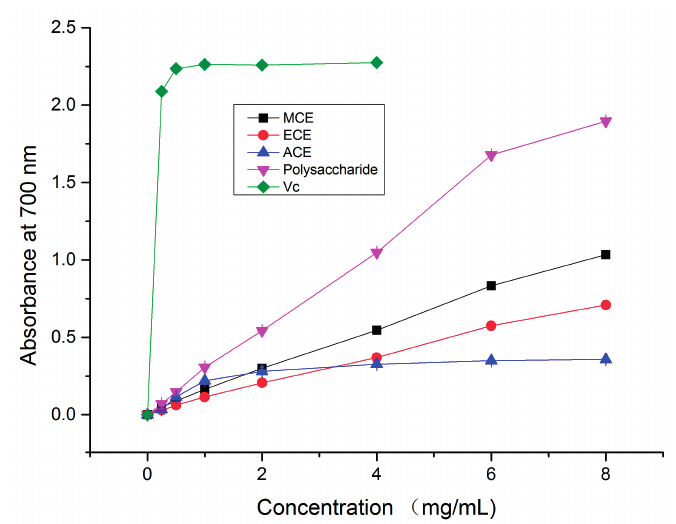
Figure 4. Comparison of reducing power of different extracts and Vc by spectrophotometric detection of the Fe 3+ –Fe 2+ transformation at 700 nm. MCE: methanolic crude extract; ECE: ethanolic crude extract; ACE: aqueous crude extract.